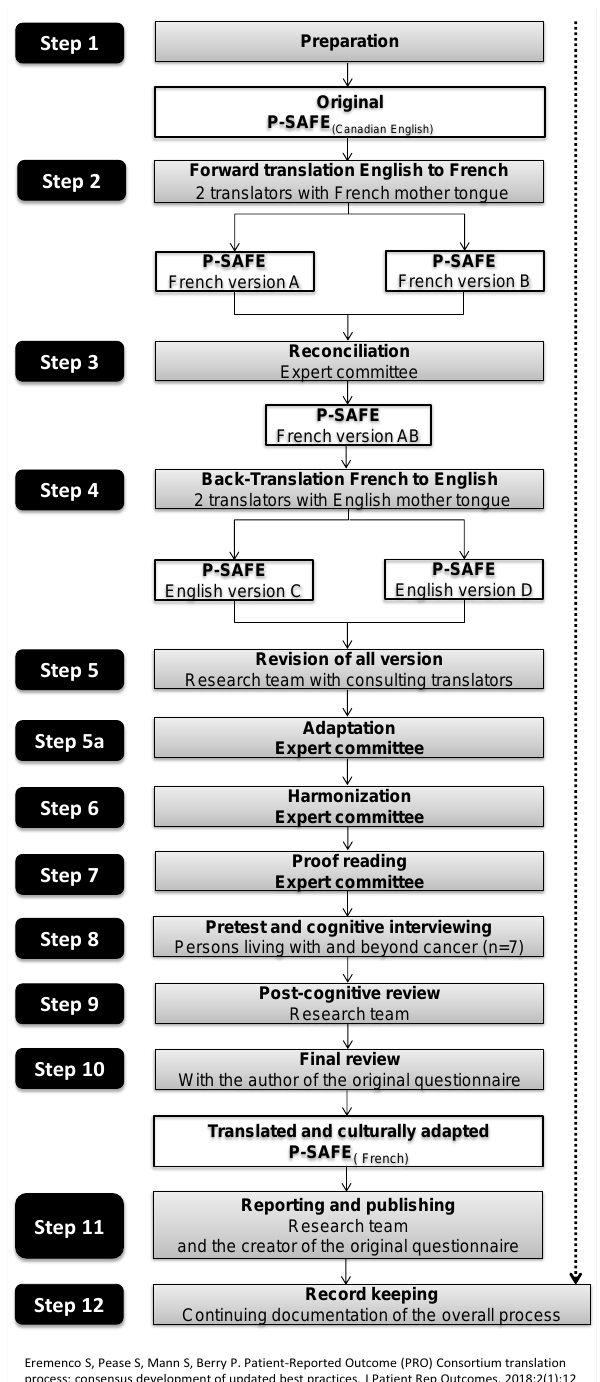
Figure 1. Translation and cultural adaptation flow diagram (adapted from Erememco et al. 2018) [39].